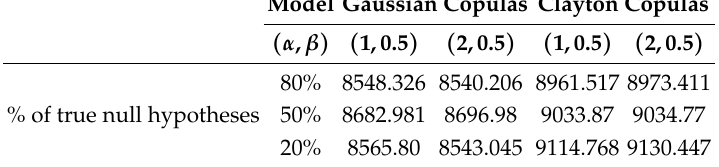
Table 7. DIC values for the different percentages of true null hypotheses and for the prior distributions of p i skewed to the